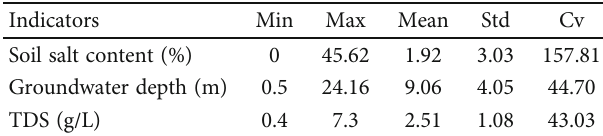
Table 2: Statistical characteristic values of soil salt content, groundwater, and